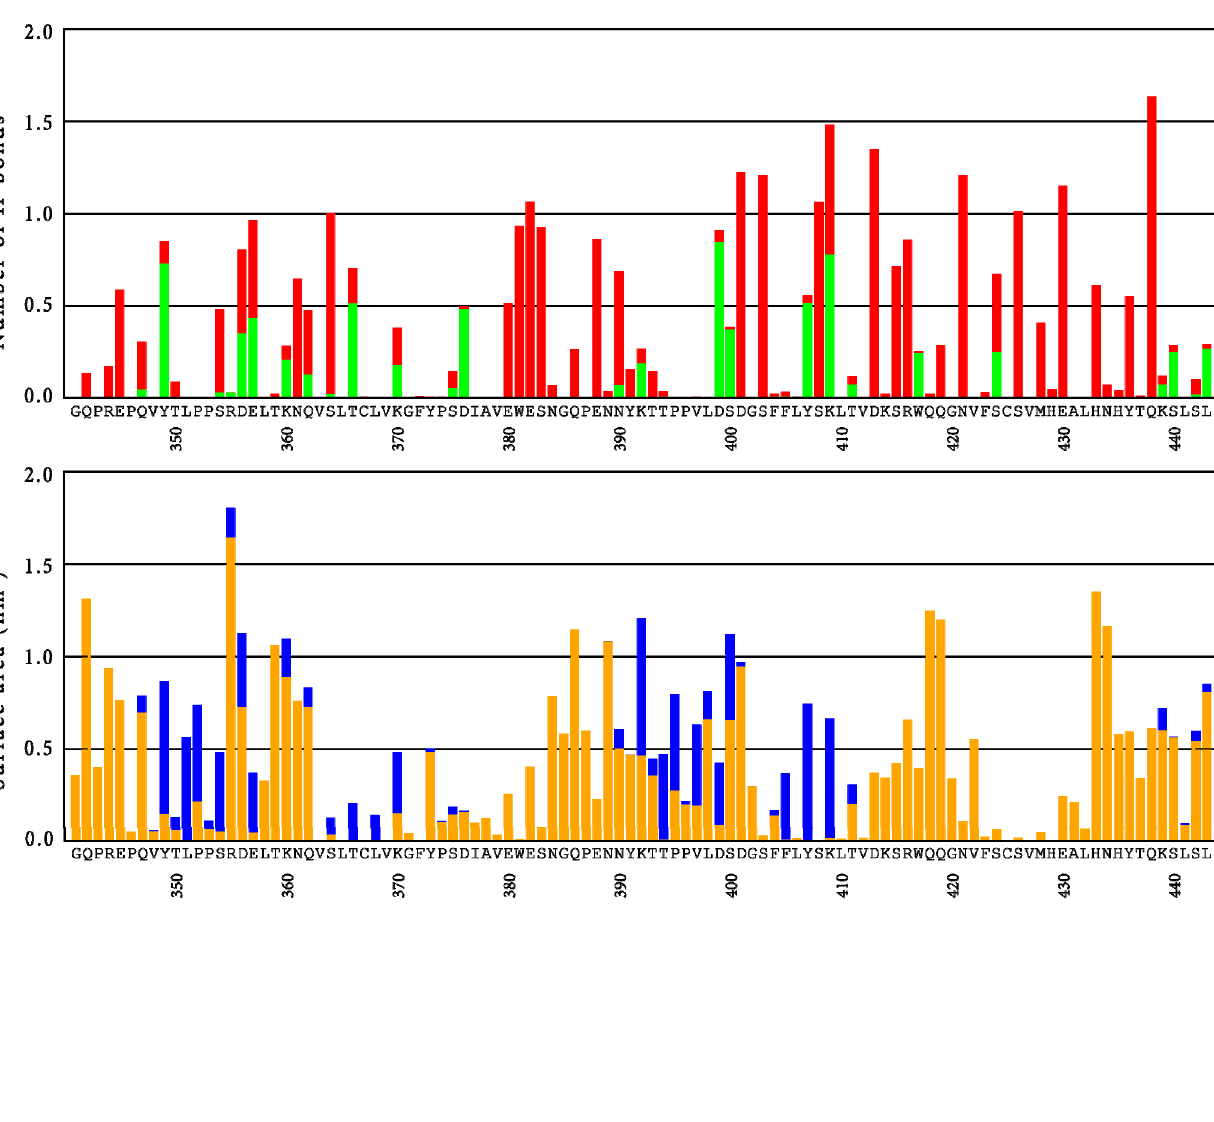
Figure 4. Top panel : Average number of hydrogen bonds (excluding backbone-backbone interactions) per residue of the CH3 domain, as observed in simulation H7. The green fraction of the bars indicate hydrogen bonds between chains A and B. Bottom panel : Average surface area per residue of the CH3 domain, as observed in simulation H7. Orange bars indicate solvent accessible surface area; blue bars indicate interfacial area between chains A and